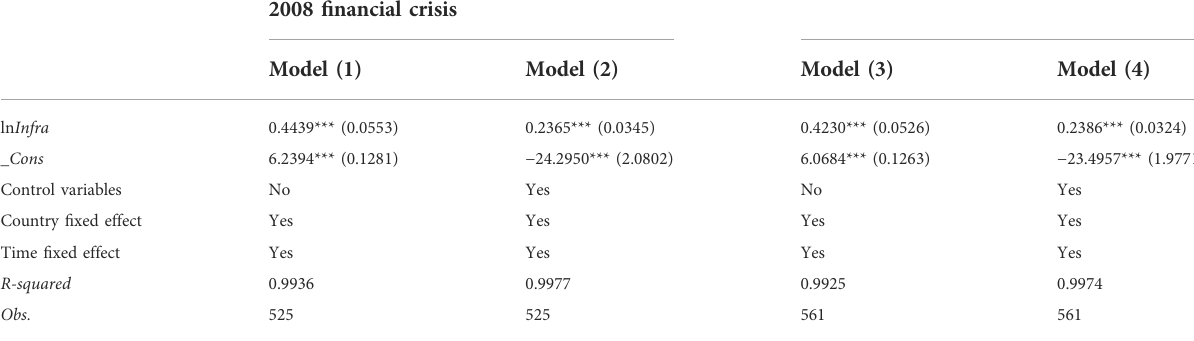
TABLE 6 Robust results of removing the distractions of the 2008 fi nancial crisis and eliminating the in fl uence of special values.